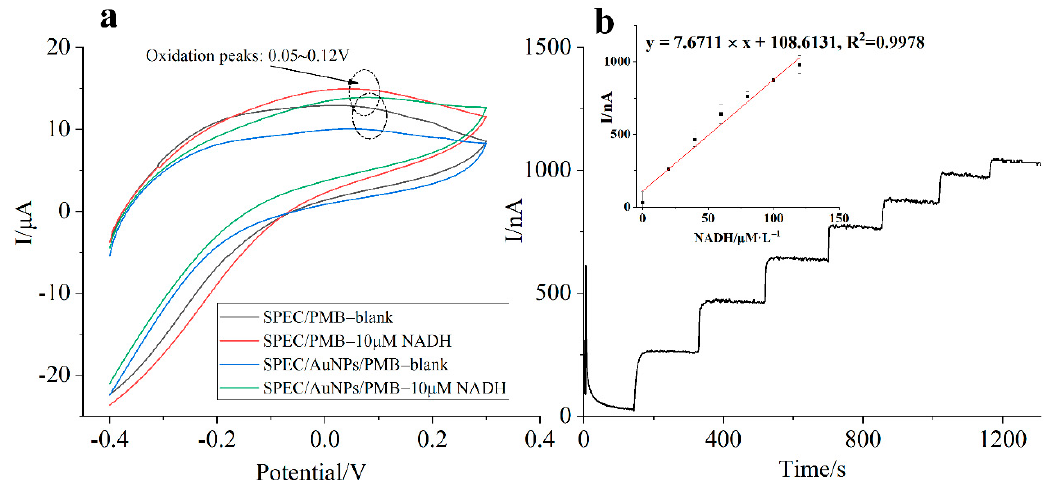
Figure 6. Cyclic voltammograms of SPEC/PMB electrode and SPEC/AuNPs/PMB electrode in blank and buffer solution containing 10 µ M NADH at a scan rate 100 mVs − 1 ( a ), amperometric response of SEPC/AuNPs/PMB electrode to different concentrations of NADH at +0.1 V, pH 7.5 and 25 °C ( b ).